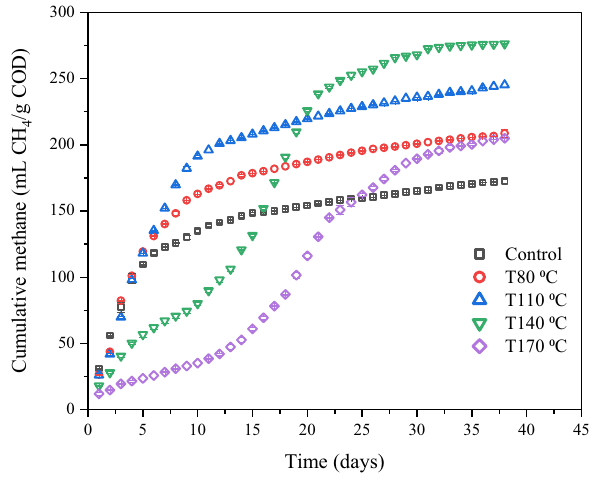
Figure 2. Cumulative methane production for raw and pretreated samples. Note: yields were calculated based on the initial COD of